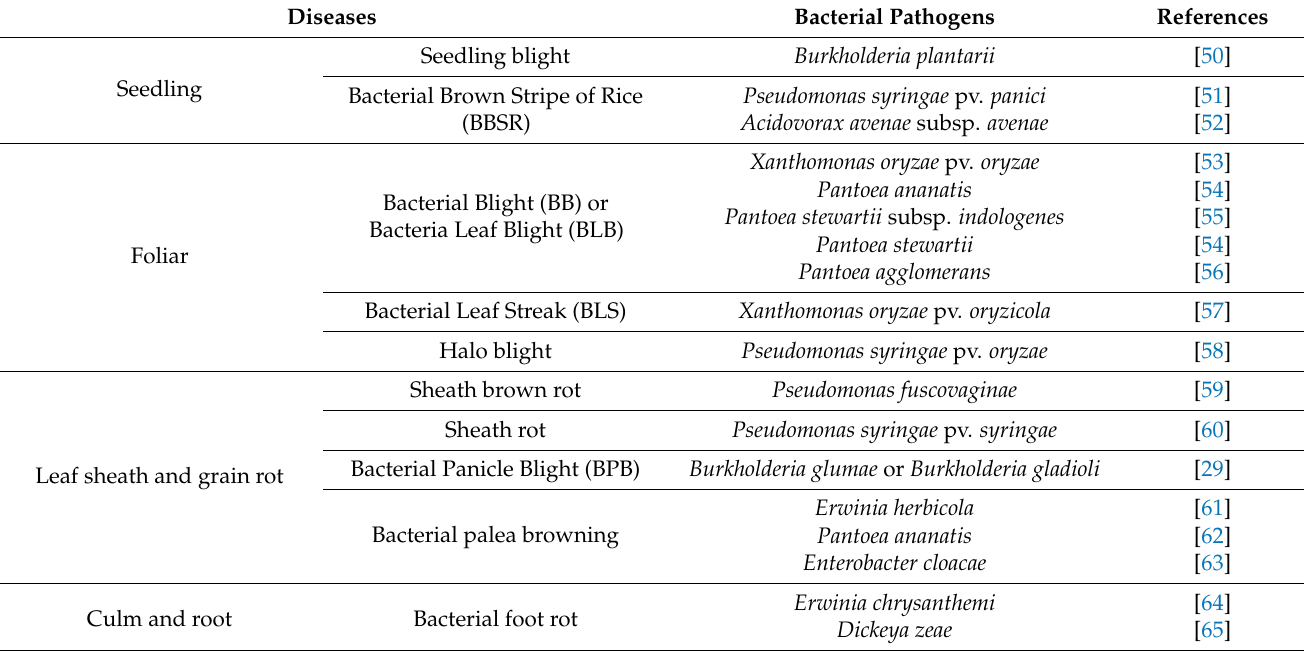
Table 1. Bacterial rice pathogens and related